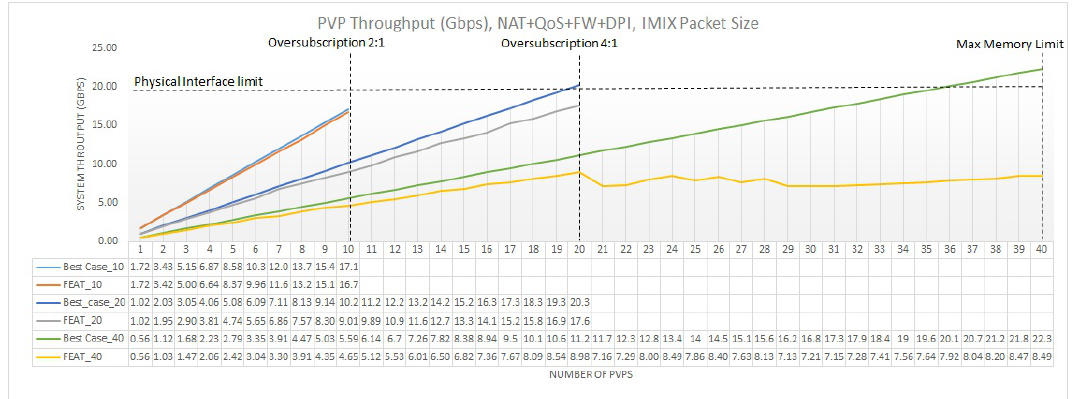
Figure 12. Multi-Feature multi-PVP system throughput with NAT, QoS, FW, and